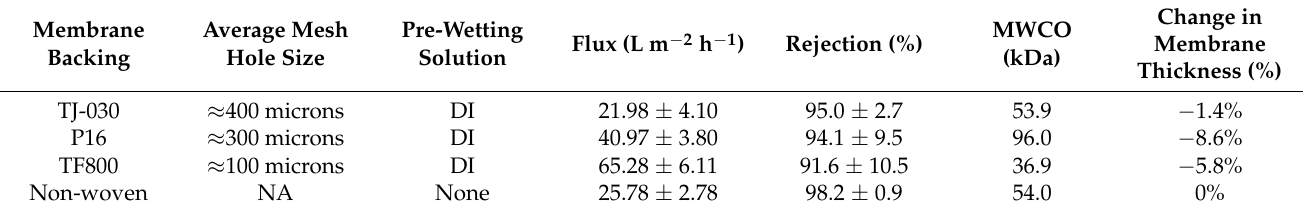
Table 3. Effect of average mesh hole size on the membrane performance. The membrane performance was evaluated with a pressure of 15 bar and 2000 ppm NaCl solution. Negative sign indicates reduc- tion in the film thickness. The MWCO data were measured on the reinforced PSf membrane